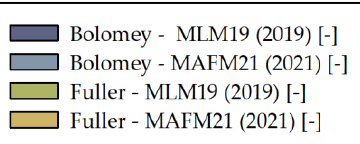
Figure 7. Errors in the comparison between designed concrete compressive strength and calculated concrete compressive strength according to MLM19 and MAFM21 formulas for four recipes designed according to the Bolomey and Fuller methods. MAE—mean absolute error; MSE—mean squared error; RMSE—root-mean-squared error.